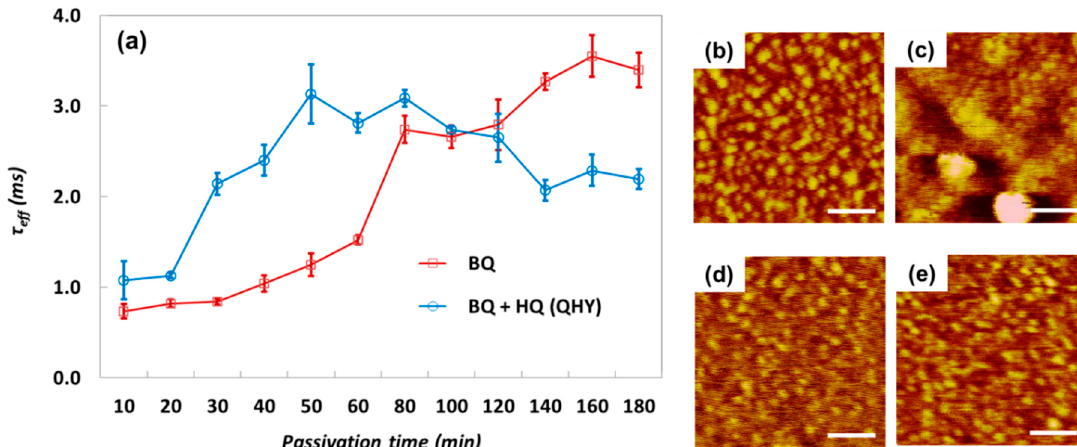
Figure 7. ( a ) Measured τ e ff after dipping in BQ and HQ / MeOH for 10 min to 180 min. HR-AFM images of Si surface after dipping in QHY / MeOH ( b , c ) and BQ / MeOH ( d , e ) for 1 h and 3 h, respectively. Table 1. SPV values measured by Kelvin Probe system compared with τ e ff from di ff erent dipping times and passivation